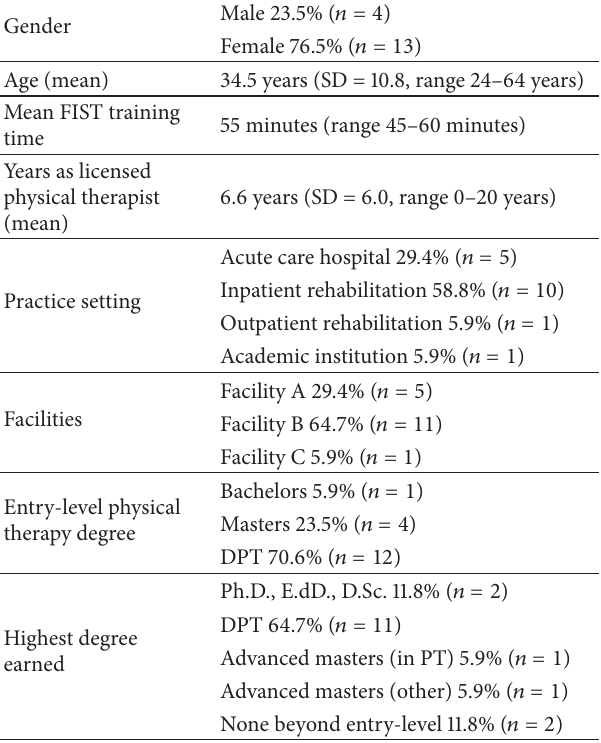
Table 2: Demographics of therapist rater participants ( 𝑛 = 17